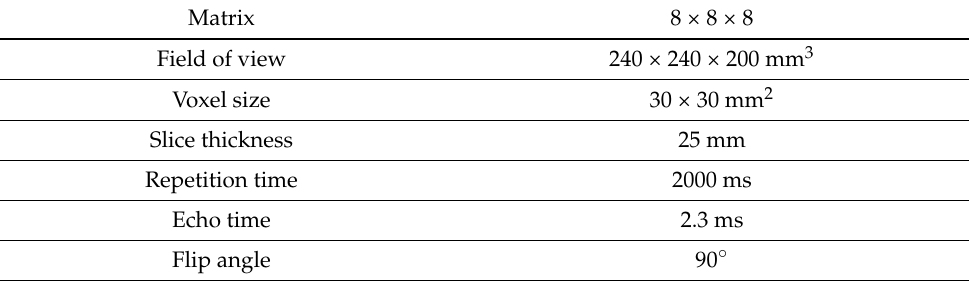
Table 2. Used parameters for 31P-MRS